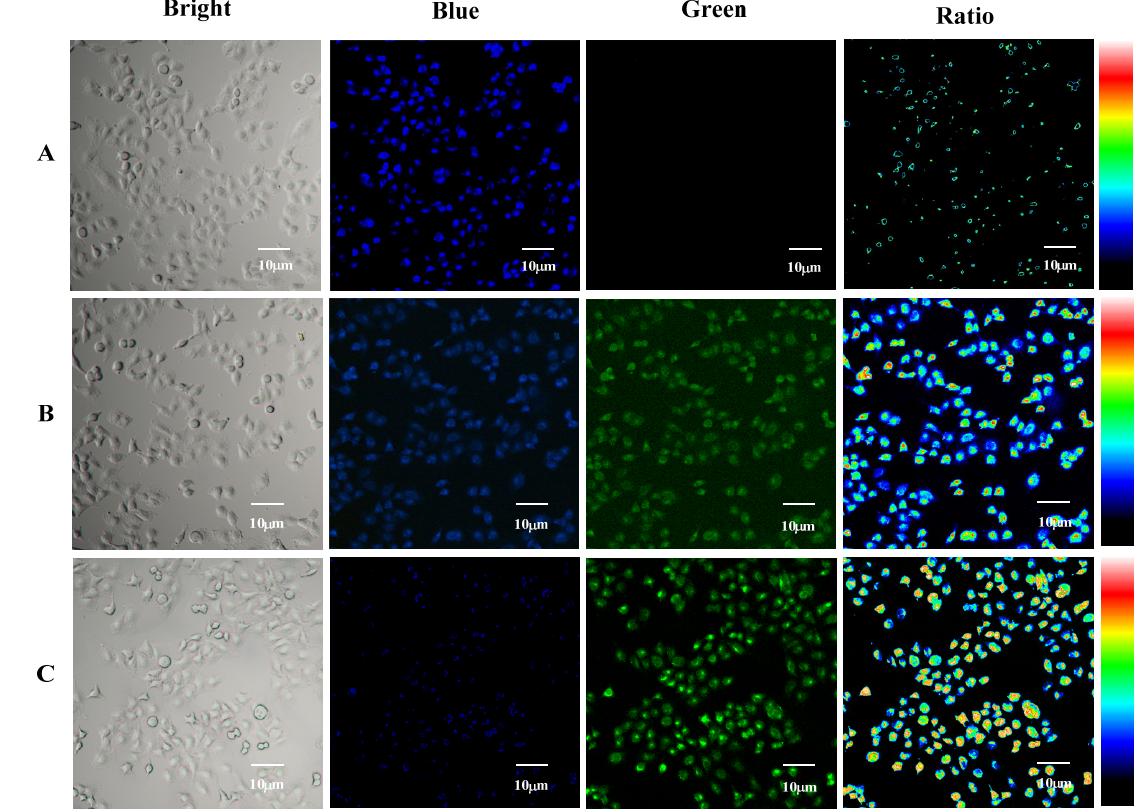
Figure 6. Fluorescence images of living A549 cells was measured with a bright, blue and green channel. Blue channel, excitation from 361 to 389 nm and emission from 430 to 490 nm; green channel, excitation from 465 to 495 nm and emission from 512 to 558; ratio, a rationmetric imaging generated from green and blue channels. ( A ) A549 cells were incubated with 1 µ M Q7 for 6 h, ( B ) A549 cells were incubated with 10 µ M (Sec) 2 for 6 h, then with 1 µ M Q7 for 10 min, ( C ) A549 cells were incubated with 10 µ M (Sec) 2 for 6 h, then with 1 µ M Q7 for 30 min. Scale bar: 10 µ m.